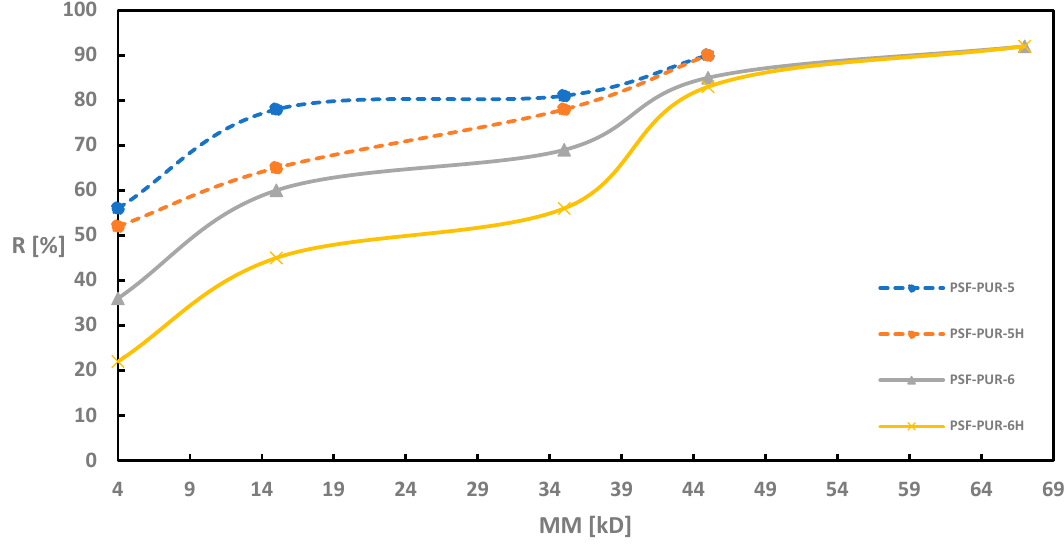
Figure 4. Retention coefficient values for different markers for PSF-PUR-5 and PSF-PUR-6 membranes before (PSF-PUR-5, PSF-PUR-6) and after (PSF-PUR-5H, PSF-PUR-6H) hydrolysis.